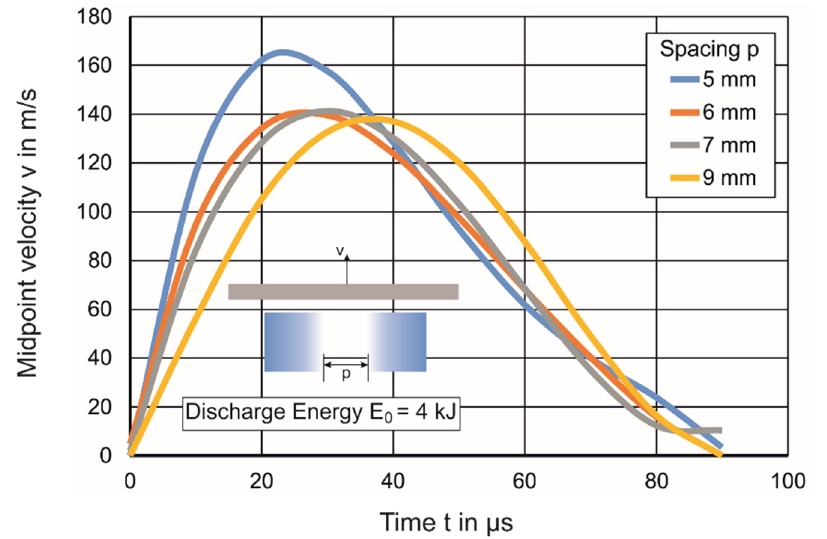
Figure 17. Comparison of experimentally measured vertical midpoint velocity for four different coil spacings.